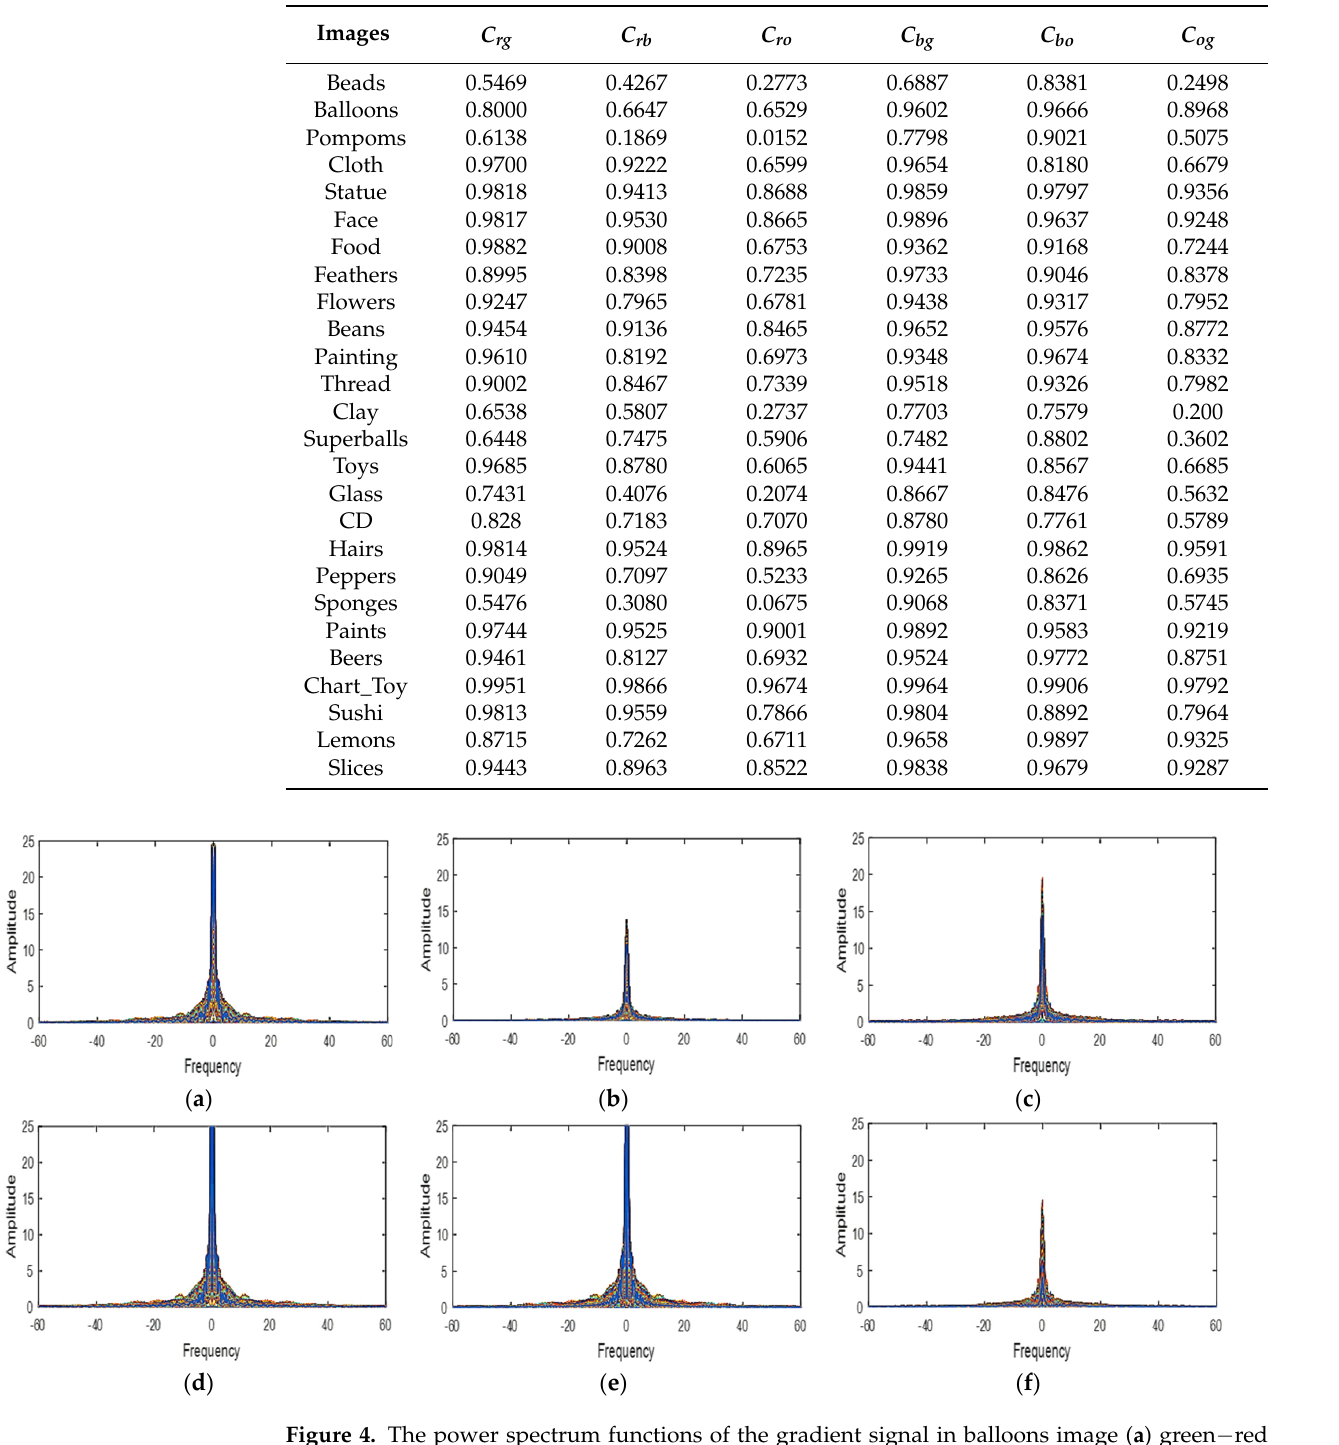
Table 1. Spectral correlation coefficients for red/green ( C rg ), red/blue ( C rb ), red/orange ( C ro ),